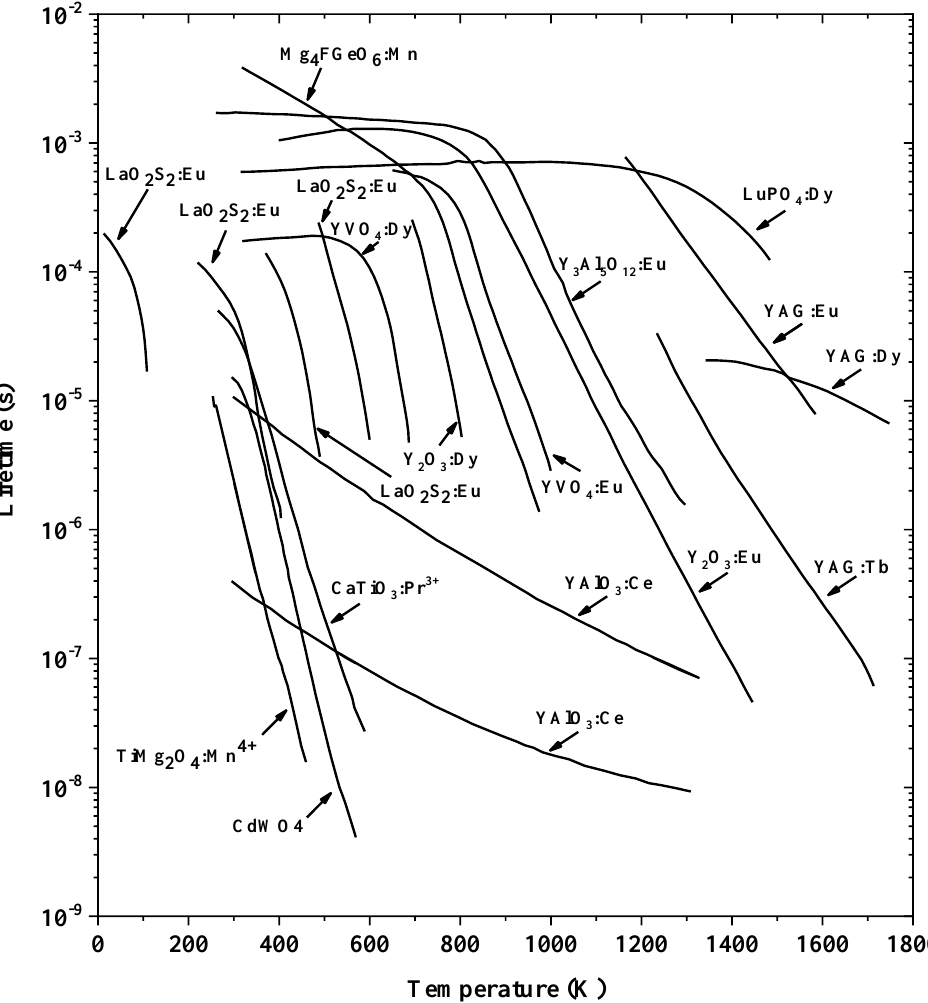
Figure 11. Lifetimeofdifferentthermographicphosphorsusedinlaser − inducedphosphorescence[5,34,76]. Generally, the phosphorescence signal is collected by a photodiode or a photomulti- plier tube (PMT) in the lifetime method. Thus, no spatial information of the temperature